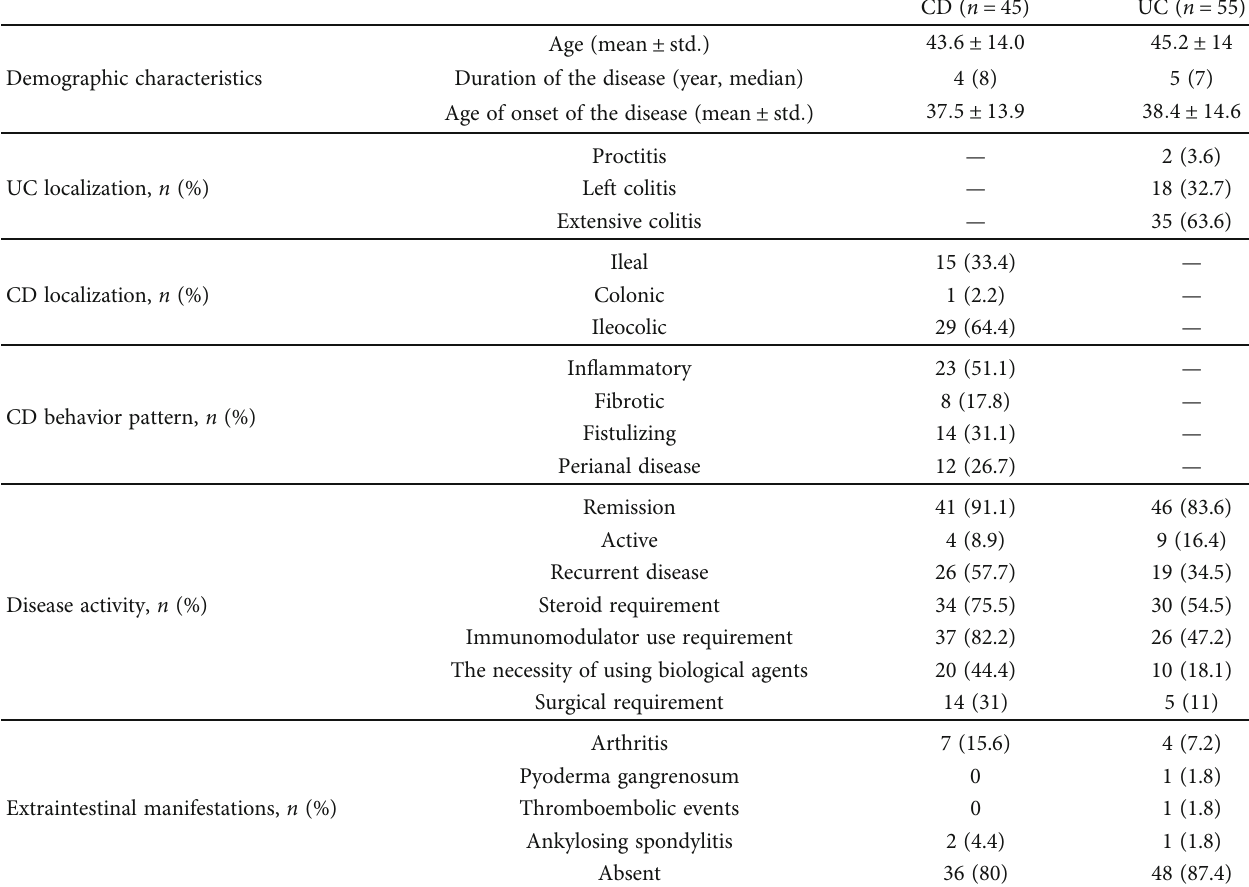
Table 1: Demographic and clinical characteristics of